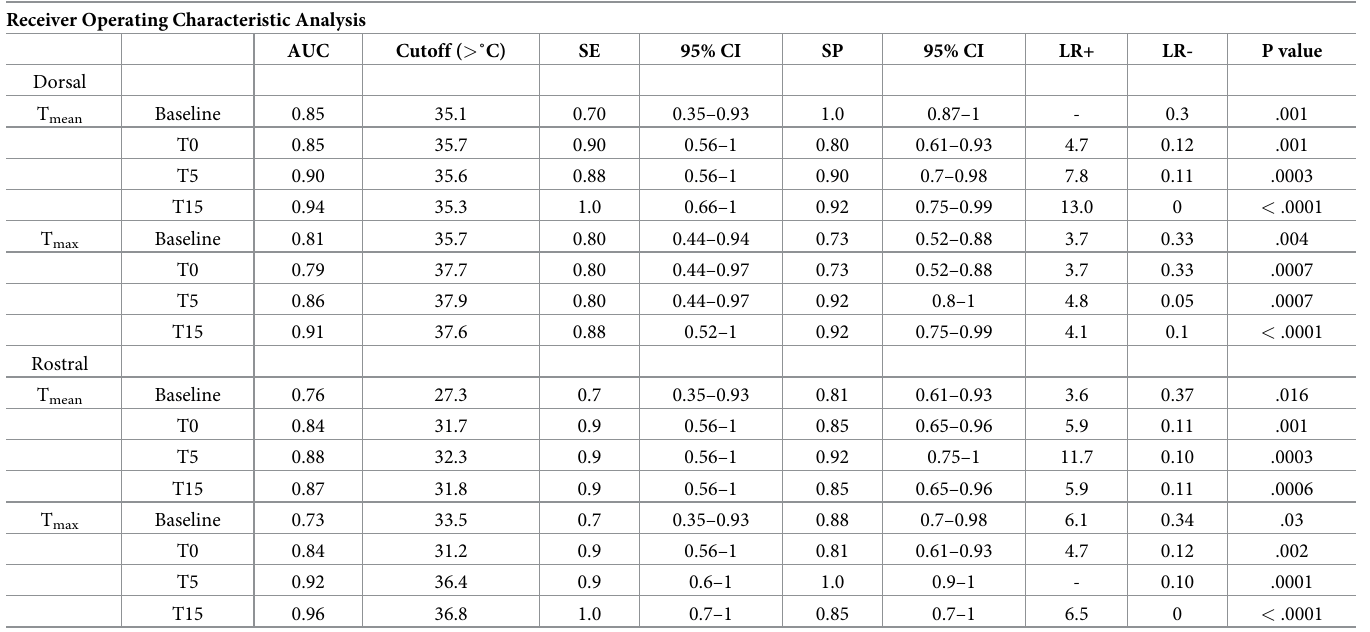
Table 7. Receiver operating characteristic analysis of BOAS and non-BOAS dogs. Receiver Operating Characteristic Analysis